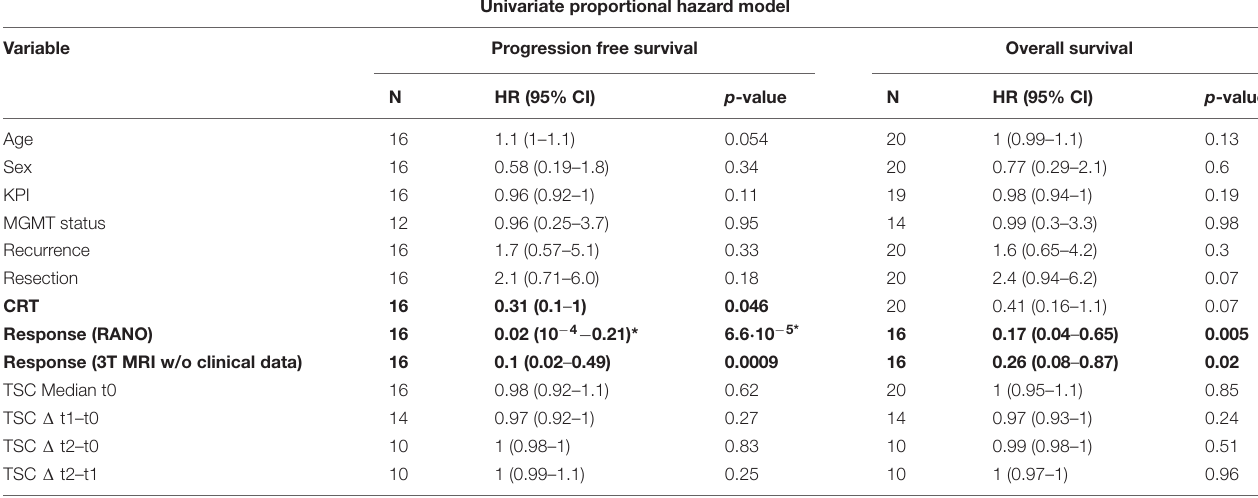
Univariate proportional hazard